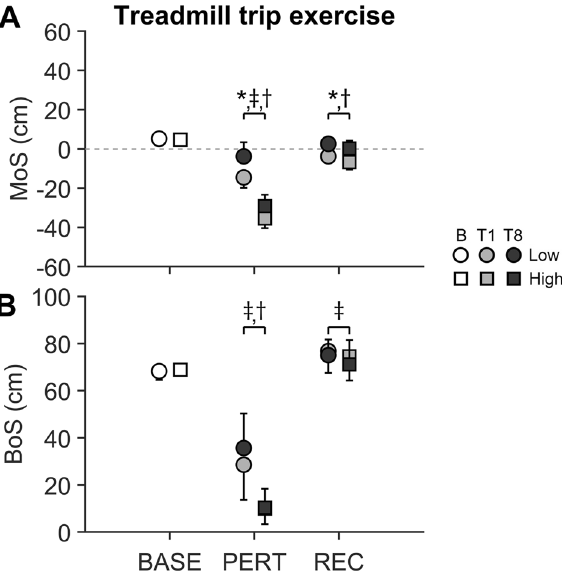
Figure 2. Margin of stability (MoS, A ) and base of support (BoS, B ) for unperturbed baseline walking (B, BASE) and for the first (T1) and eighth (T8) trials of treadmill-based perturbation exercise for Low ( n = 10) and High ( n = 10) perturbation magnitude groups. Data for T1 and T8 is shown for left foot touchdown after perturbation (PERT) and for the right foot touchdown for the subsequent recovery step (REC). Note that PERT at T1 and T8 (9.9 ± 6.9 cm and 10.4 ± 8.5 cm respectively) showed quite similar average values for the high perturbation magnitude group. Values are presented as averages with standard deviation error bars. ‡, * and † indicate significant differences. ‡ BASE vs. T1 and T8 for low and high groups ( P < 0.05); * T1 vs. T8 for low and high groups ( P < 0.001); † low vs. high groups at T1 and T8 ( P <